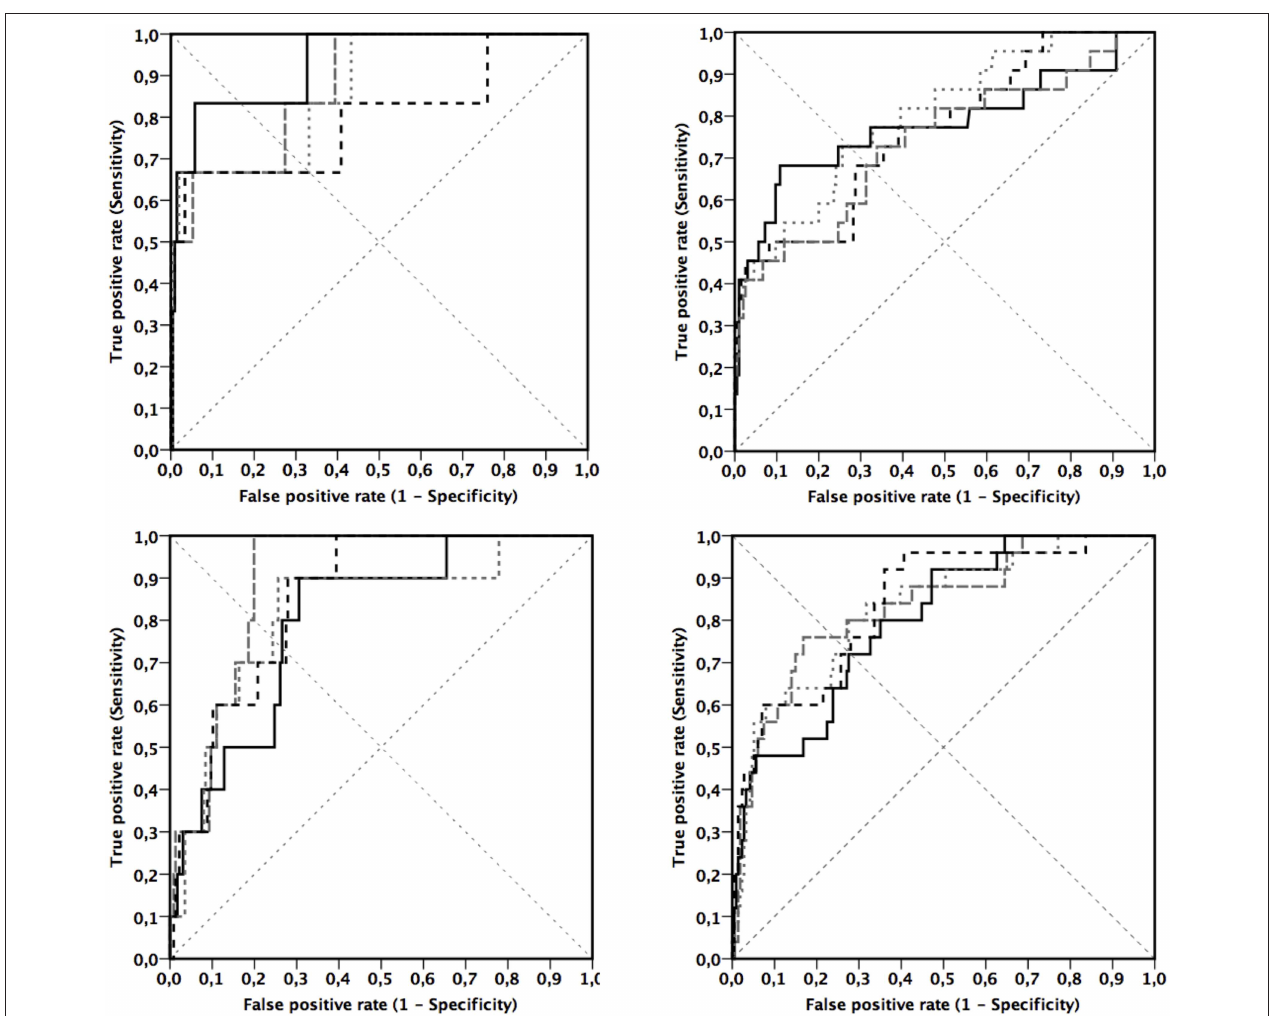
FIGURE 1 | Receiver operating characteristic curves between the measures of adiposity and cardiometabolic risk in girls (Upper) and in boys (Lower) . Endpoint by cardiometabolic risk has been defined by pediatric metabolic syndrome (33) (Left) and using 90th (Right) percentile threshold for cardiometabolic score. Components of cardiometabolic score were serum insulin and plasma high-density lipoprotein cholesterol, triglycerides, gamma-glutamyl transferase, high-sensitivity C-reactive protein, and uric acid. Black lines represent waist-to-height ratio (___), body fat percentage by dual-energy X-ray absorptiometry (- - -), gray lines represent body mass index standard deviation score (_ _ _), and body fat percentage by bioimpedance analysis